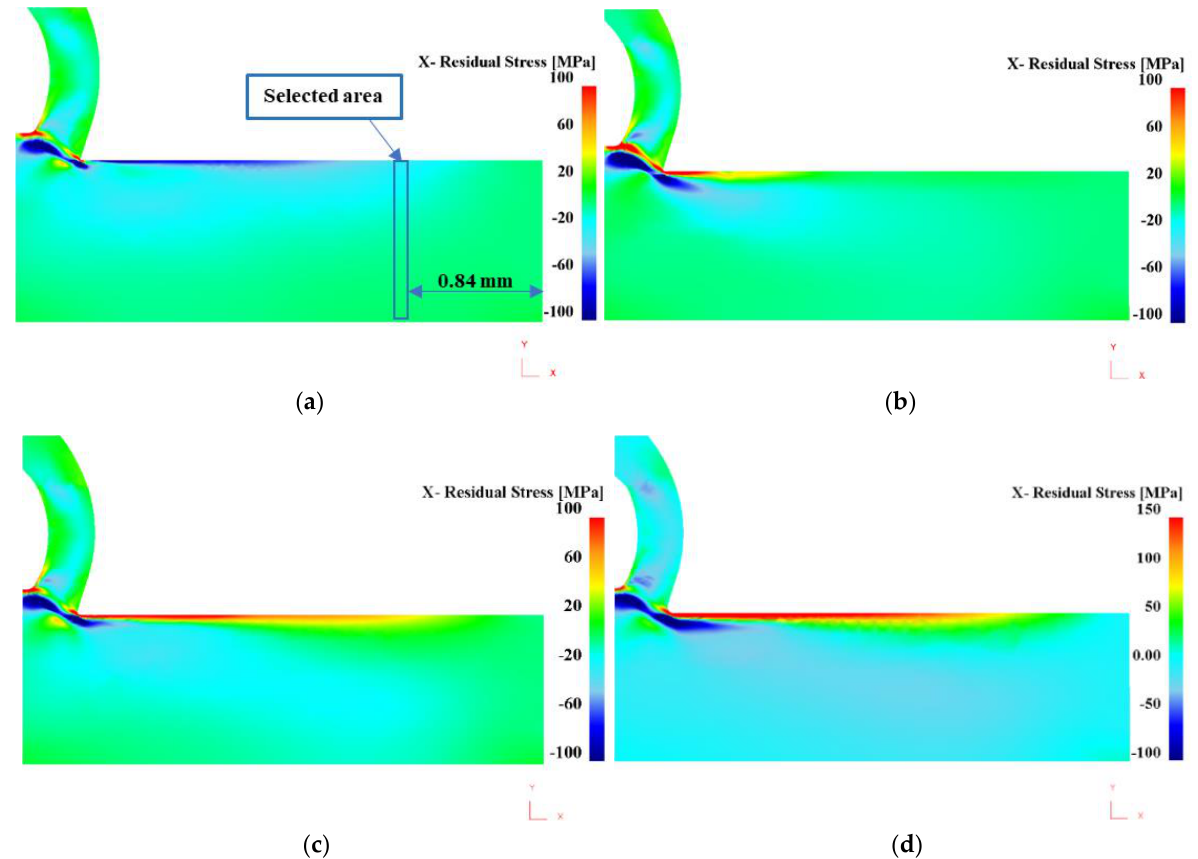
Figure 9. Residual stresses simulations with respect to the edge radius: ( a ) 5 µm, ( b ) 10 µ m, (𝐜) 20 µm , and ( d ) 40 µ m .